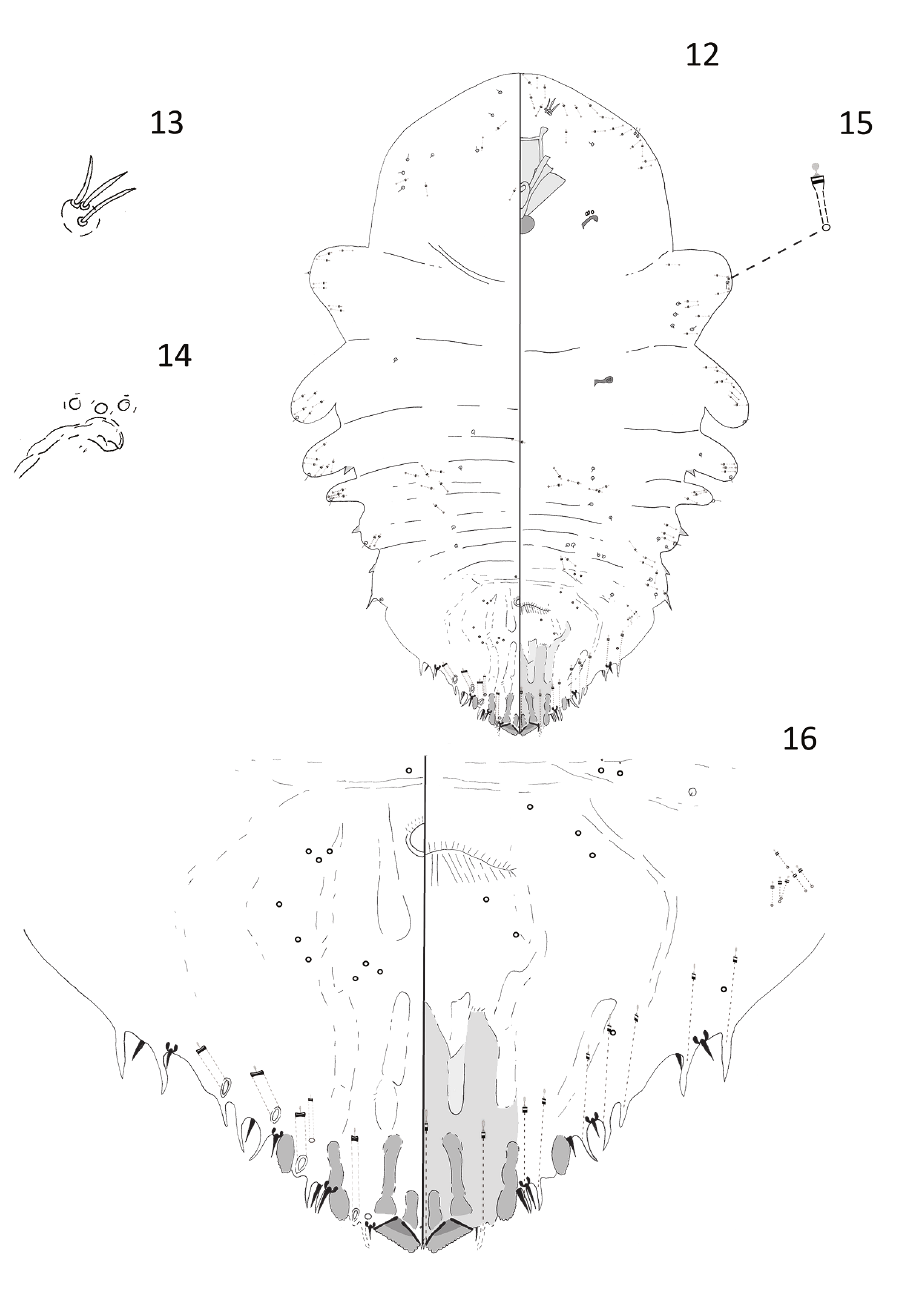
Figure 12–16. Andaspis nothofagi Hamilton and Williams, sp. n., adult female; 12 whole body 13 an- tenna 14 anterior spiracle 15 microduct 16